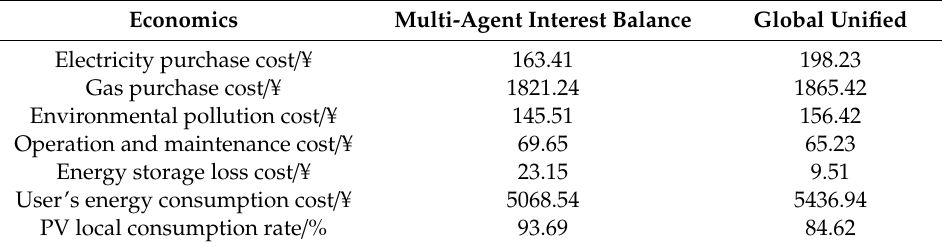
Table 6. Comparison of economics of and PV consumption under di ff erent dispatch